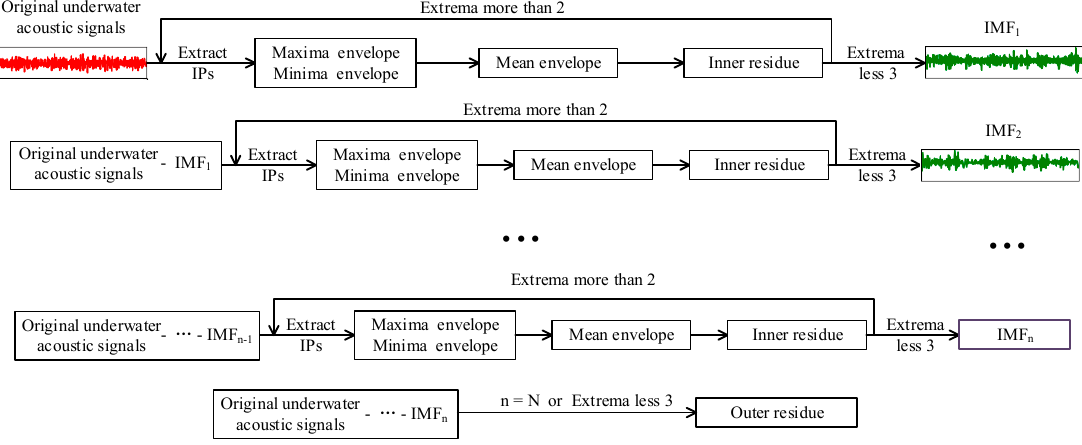
Figure 6. The flowchart of modified empirical mode decomposition (MEMD).